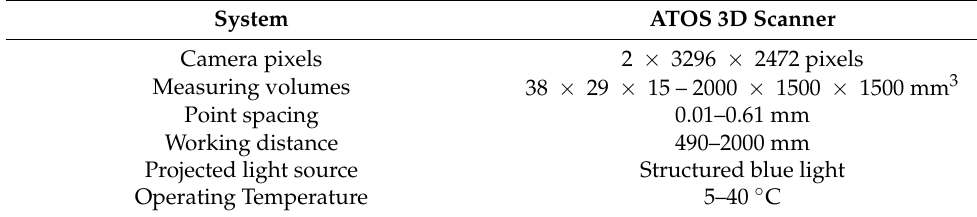
Figure 2. ( a ) ATOS 3D Scanner, ( b ) a face gear, and ( c ) the point cloud collection. Table 1. The configuration of ATOS 3D